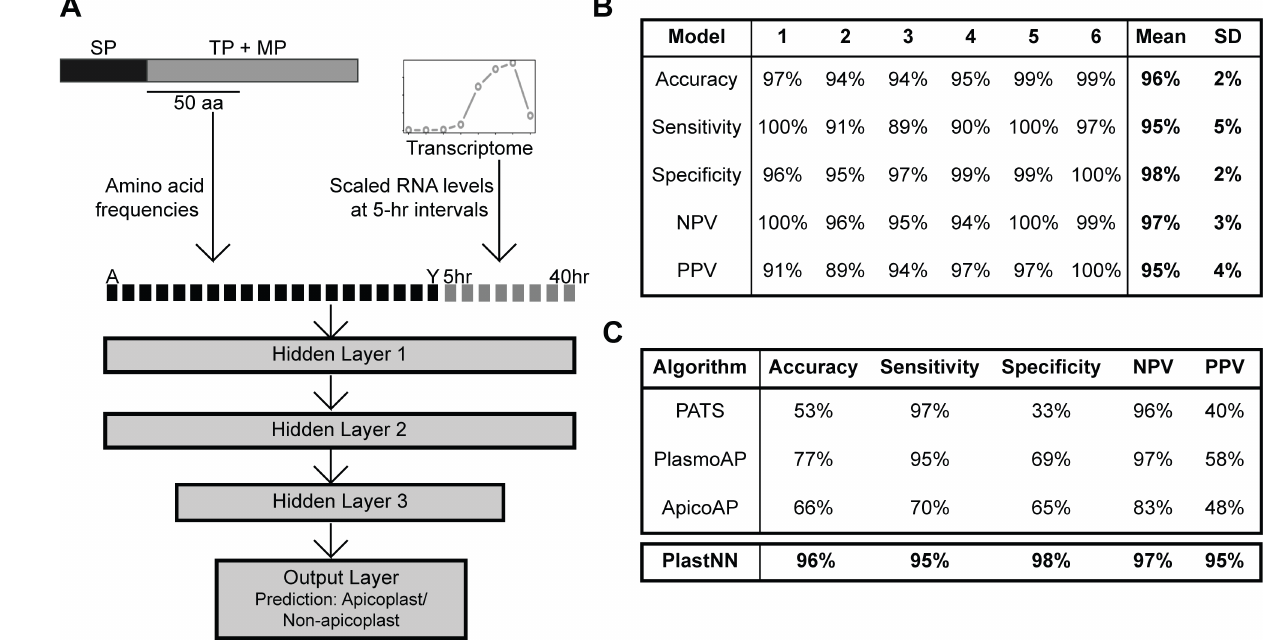
Fig 4. Improved prediction of apicoplast proteins using the PlastNN algorithm. (A) Schematic of the PlastNN algorithm. For each signal peptide- containing protein, a region of 50 amino acids immediately following the signal peptide cleavage site was selected, and the frequencies of the 20 canonical amino acids in this region were calculated, resulting in a vector of length 20. Scaled RNA levels of the gene encoding the protein at 8 time points were added, resulting in a 28-dimensional vector representing each protein. This was used as input to train a neural network with 3 hidden layers, resulting in a prediction of whether the protein is targeted to the apicoplast or not. (B) Table showing the performance of the 6 models in PlastNN. Each model was trained on five-sixths of the training set and cross-validated on the remaining one-sixth. Values shown are accuracy, sensitivity, specificity, NPV, and PPV on the cross-validation set. The final values reported are the average and standard deviation over all 6 models. (C) Comparison of accuracy, sensitivity, specificity, NPV, and PPV for 3 previous algorithms and PlastNN. NPV, negative predictive value; PlastNN, Apicoplast Neural Network; PPV, positive predictive